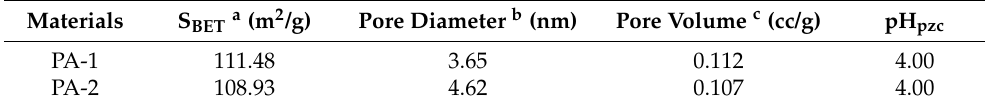
Table 3. BET characterization results of the PA-1 and PA-2.